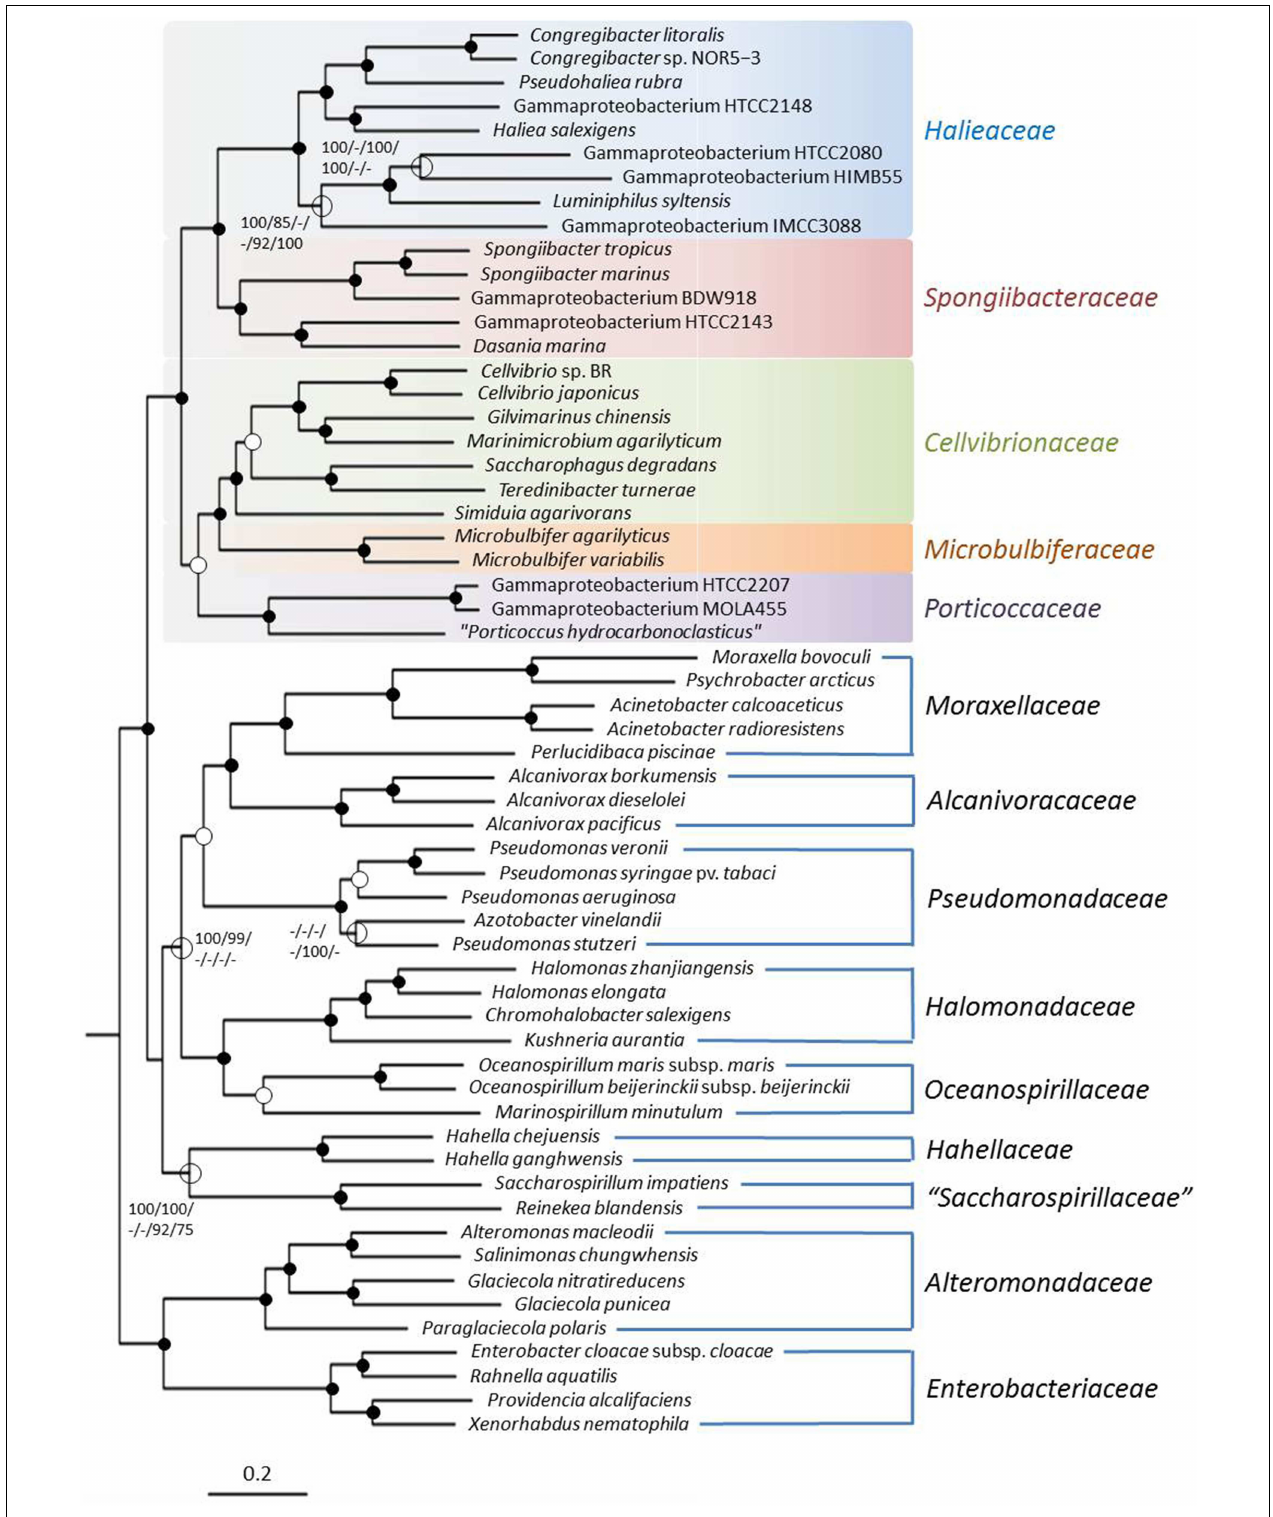
FIGURE 2 | Phylogenetic tree inferred from the 2,801,974 aligned amino acid character containing supermatrix. The tree topology was reconstructed under the maximum likelihood criterion and was rooted with Magnetococcus marinus MC-1 T (not shown). Black dots at a distinct node